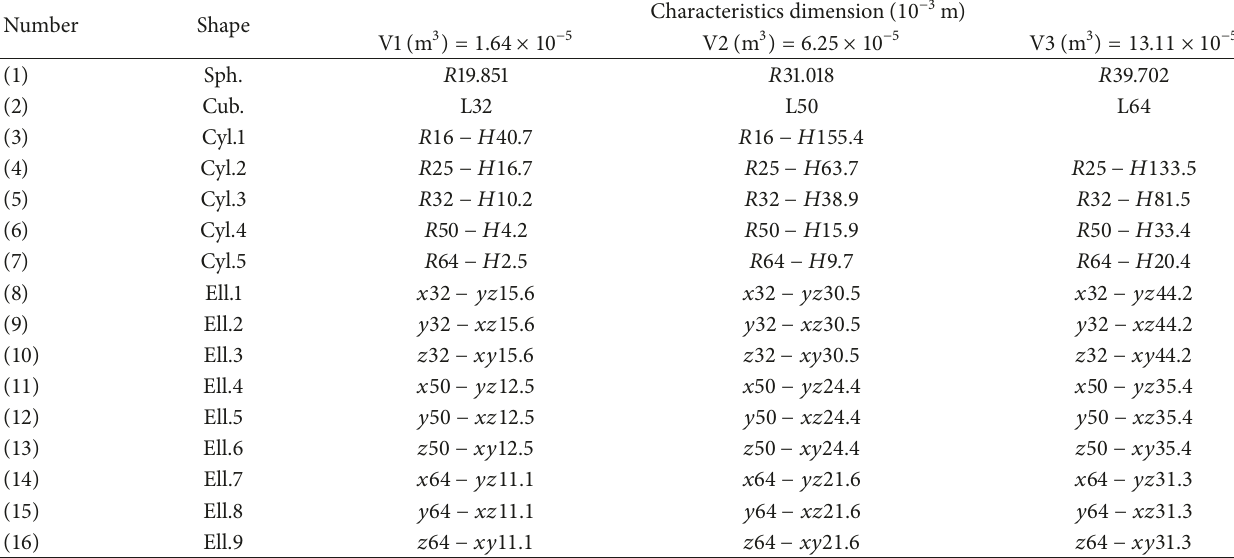
Table 2: Geometric characteristics dimension of different shape potato samples.